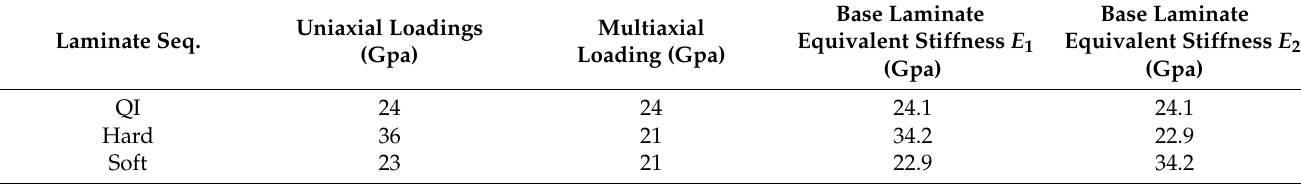
Figure 6. Variation of load-bearing capacity for different laminates subjected to uniaxial and multiaxial loading. Table 3. Optimum values of the stiffnesses of the filling material for different laminate sequences subjected to uniaxial and multiaxial loading .